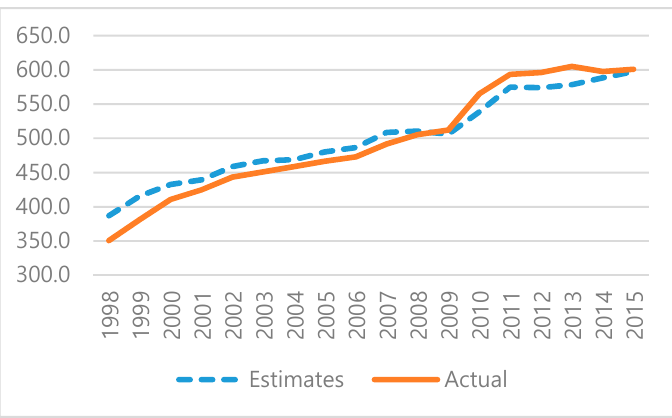
Figure 1. CO 2 Emissions in Korea (mil. ton of CO 2 eq).